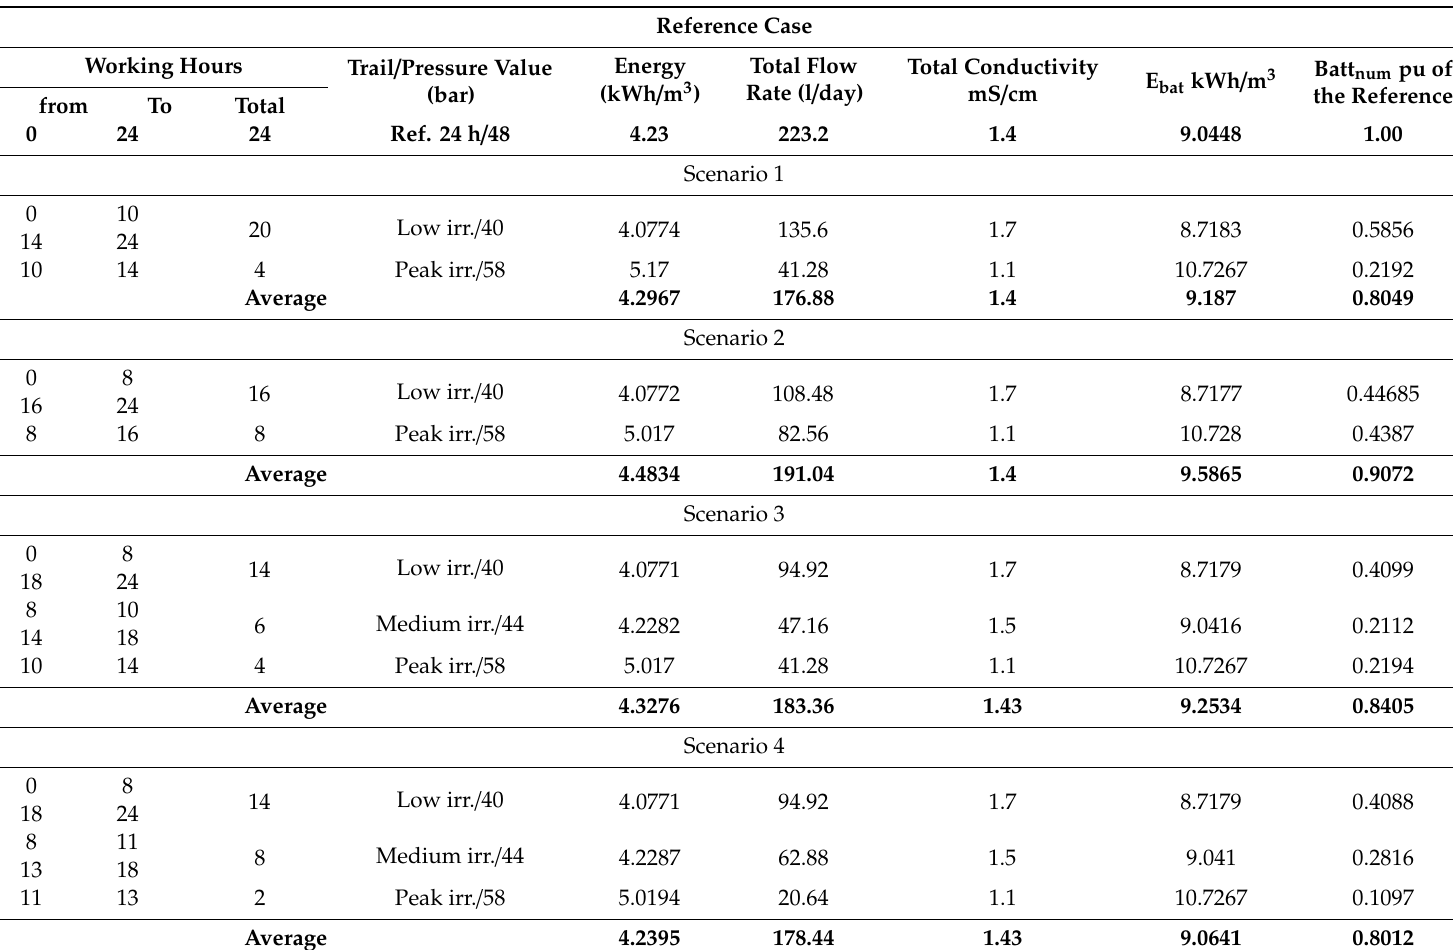
Table 3. Battery sizing for di ff erent